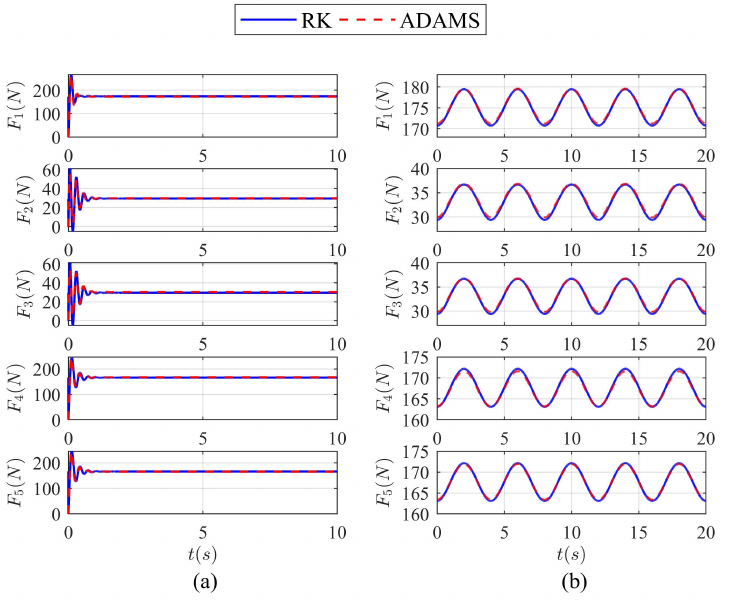
Figure 5. Comparison of the evolution of the axial forces obtained by RK method and ADAMS. ( a ) Time history plot of five axial forces under the positioning motion and ( b ) Time history plot of five axial forces under the periodic